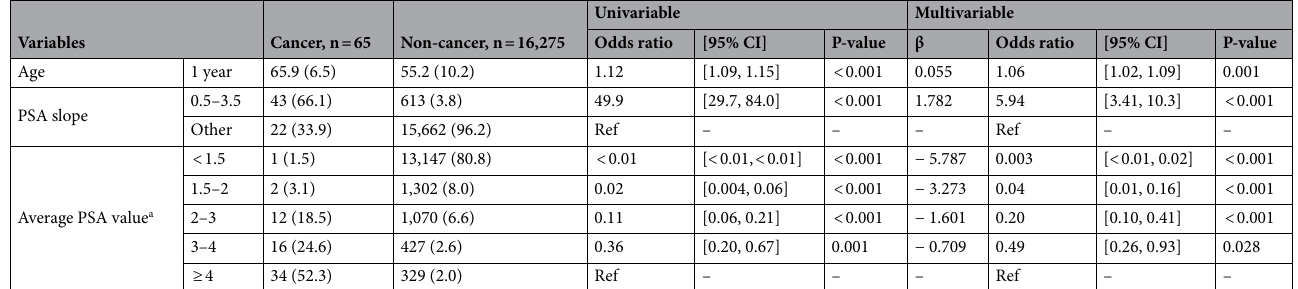
Table 1. Univariable and multivariable logistic regression analysis including age, PSA slope, and the average psa value as predictors (traning set). Continuous variable are preented as means (standard deviations). Categorical variables are presented as no. (%). CI confidence interval, PSA prostate-specific antigen. a Average of PSA measures taken at two or three time